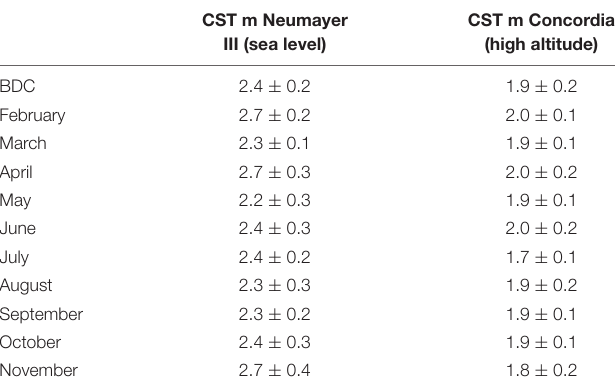
TABLE 3 | Psychometric data of